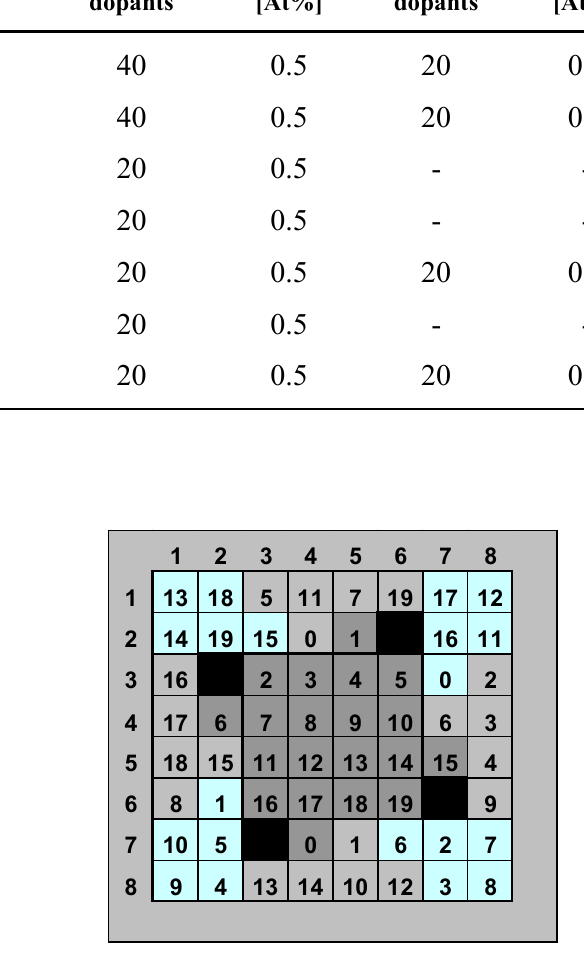
Figure 4. Equal distribution of sensor with 20 different dopants on a library due to the gas flow of the HT-IS setup. Each sensor is deposited three times for reproducing reasons, black fields represent the undoped